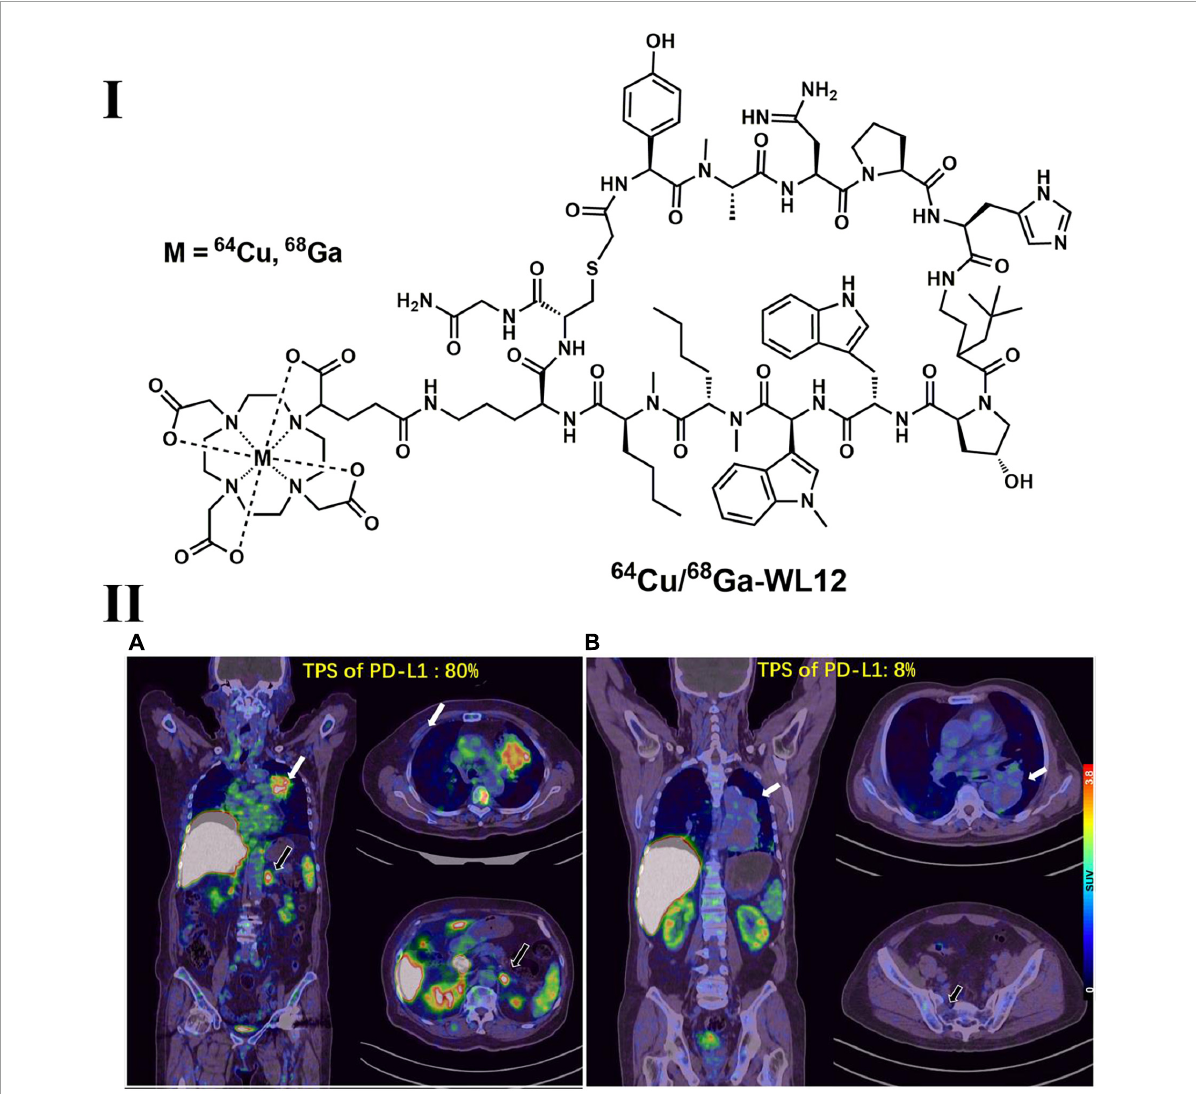
FIGURE7 Structure of 64 Cu/ 68 Ga-WL12 (I) and representative PET images of 68 Ga-WL12 in patients with NSCLC (II) . (IIA) An 80-year-old patient (female) with advanced NSCLC and a PD-L1 TPS value of 80%; (IIB) a 68-year-old patient (male) with a PD-L1 TPS value of